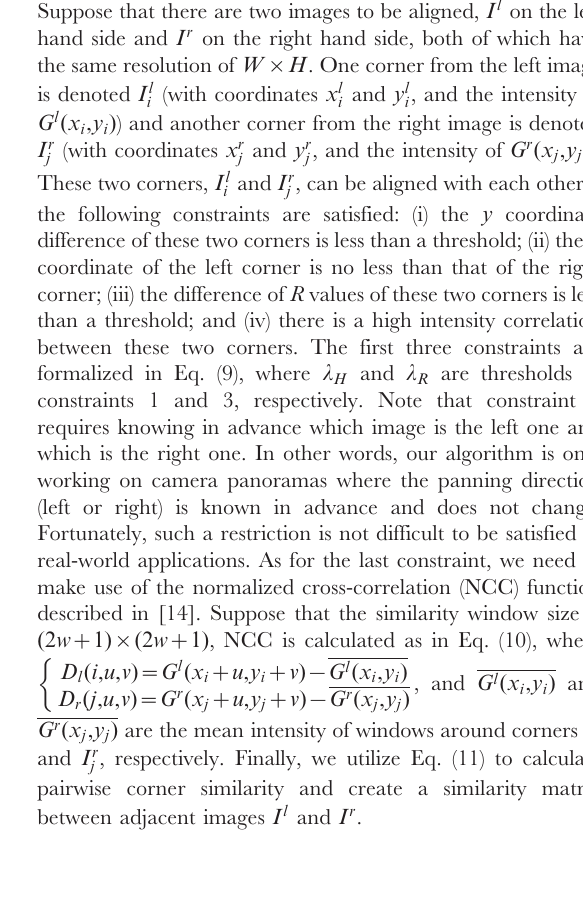
Table 5. Qualitative and quantitative amalysis on three different algorithms (II).